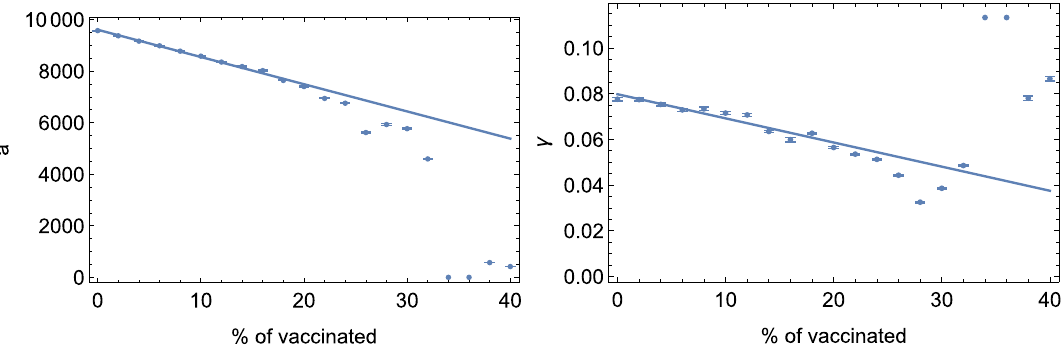
Figure 4. a and γ fit parameters versus initial percentage of vaccinated nodes for γ ∗ = 0.6 and ǫ ∗ = 0.4